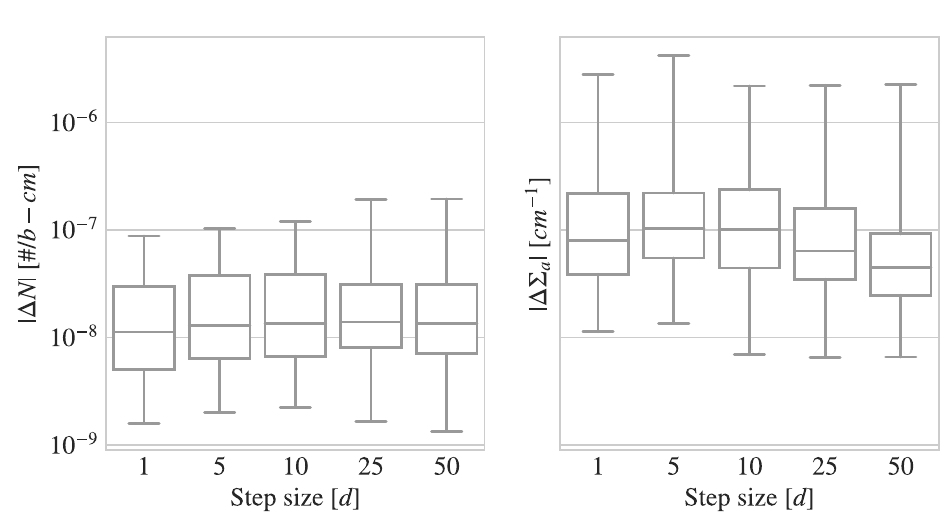
Figure 3: Distribution of errors in predicted number densities (left) and macroscopic absorption cross section (right) using custom depletion framework